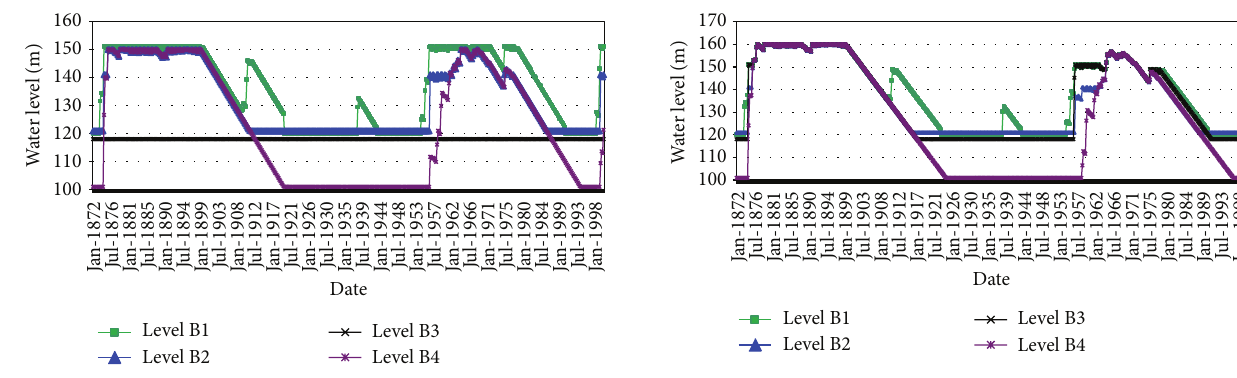
Figure 12: Water level time series for TD configuration B.